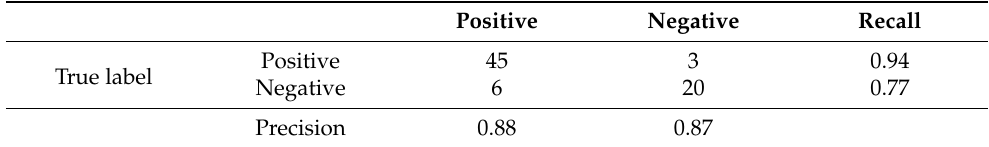
Table 3. Results of the performance per case.